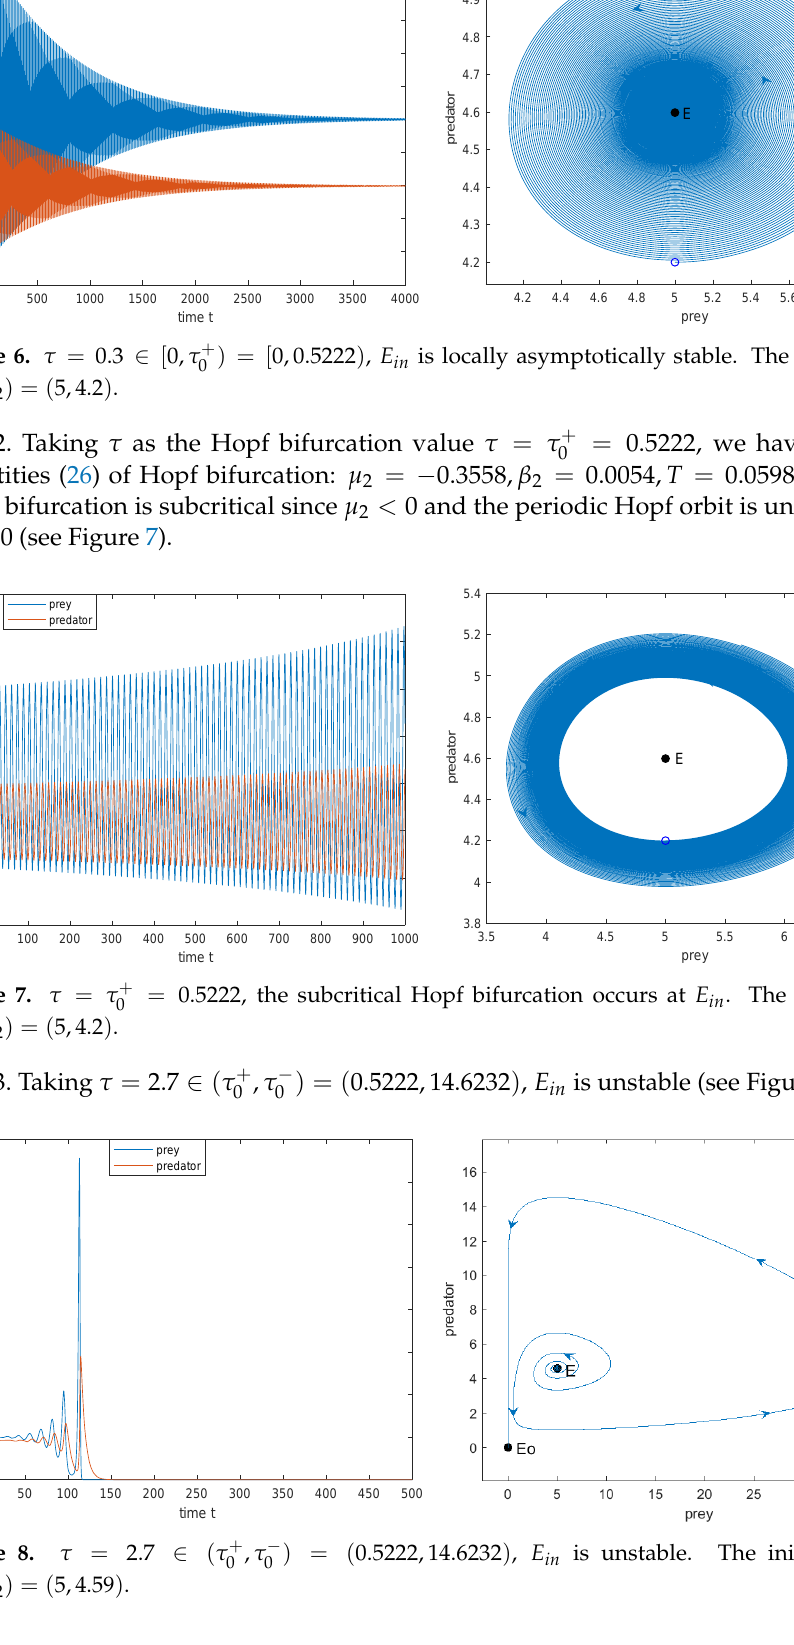
in is unstable. The initial value is